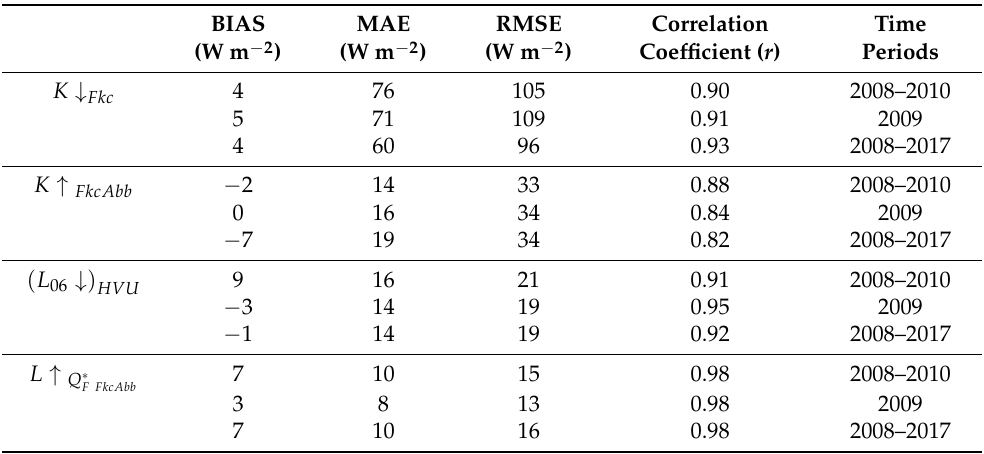
Table 15. Comparison of statistical errors between the year 2009 and the periods 2008–2010 and 2008–2017 for all components of radiation using the best parameterizations: K ↓ , K ↑ , L ↓ and L ↑ .